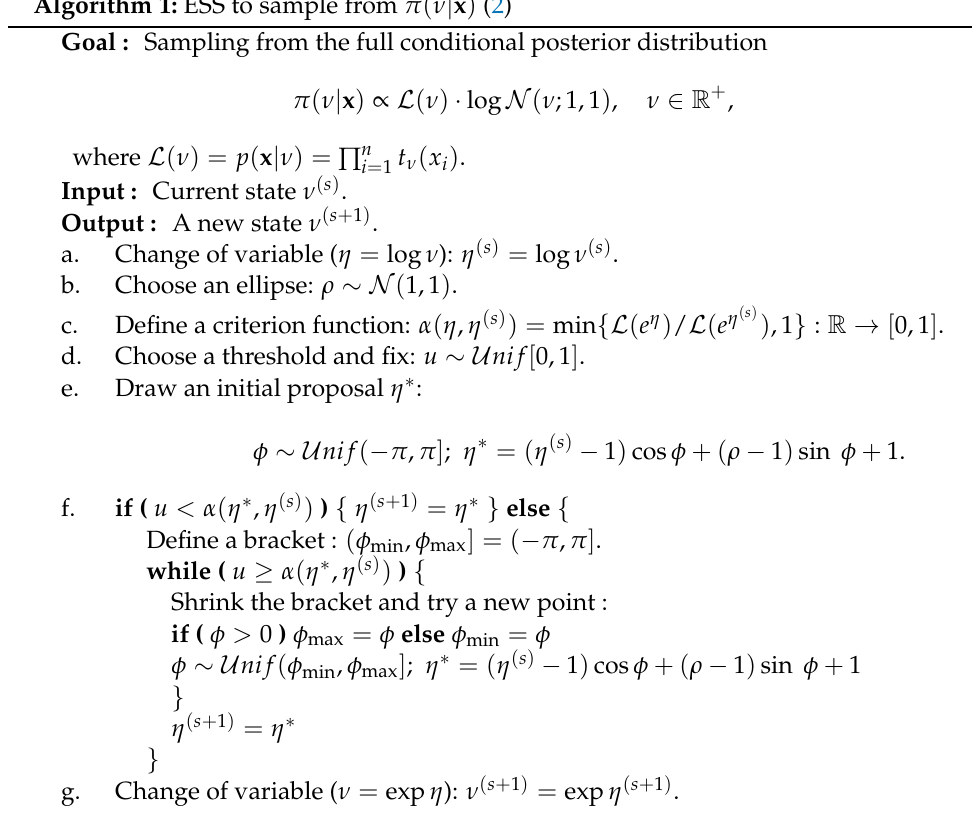
Algorithm 1: ESS to sample from π ( ν | x ) (2) Goal : Sampling from the full conditional posterior